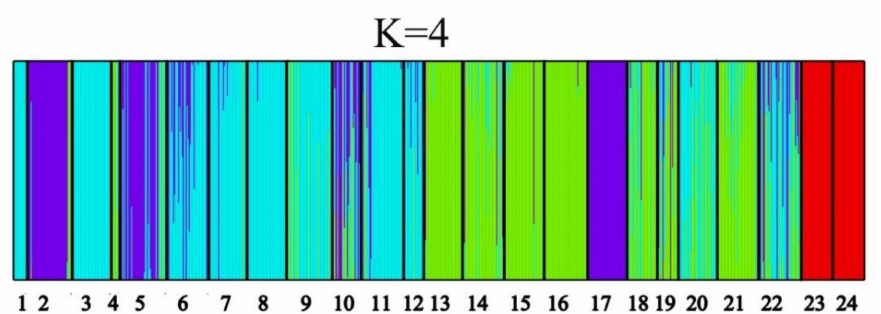
Figure 2. Population genetic structure based on the Bayesian clustering model among 871 samples at K = 4. Numbers correspond to the population numbers in Table